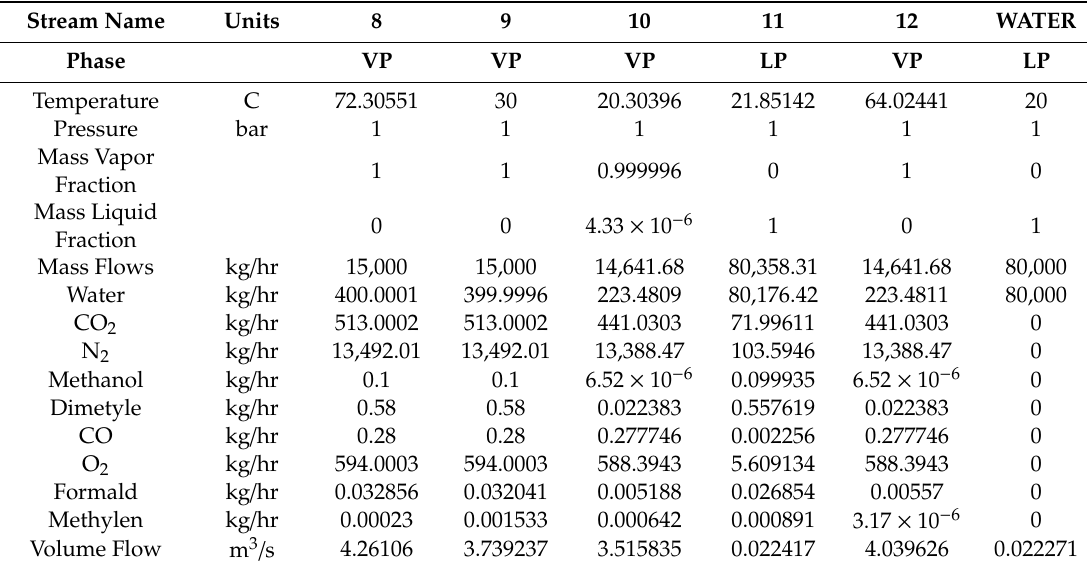
Figure 4. Computer simulation of additional waste gas treatment of metal oxide catalyst formaldehyde production processes. Table 3. The results of the computer simulation for a heat exchanger (EXCH4) and an absorber